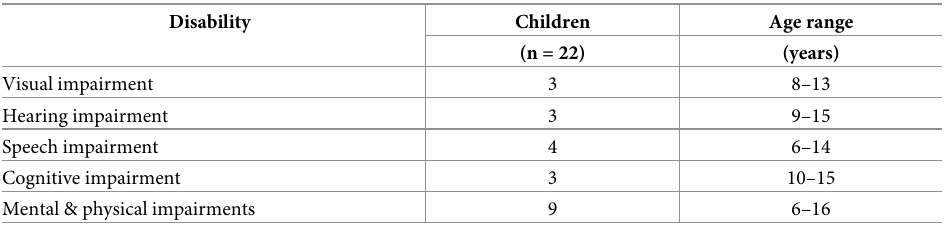
Table 1. Characteristics of the